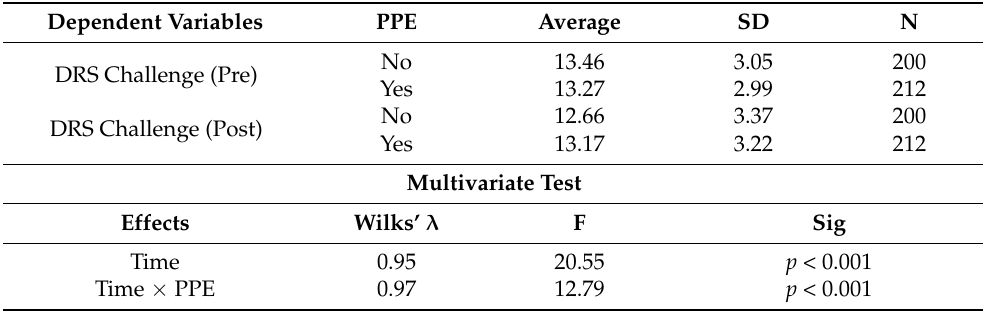
Table 12. Repeated measures ANOVA model of time (i.e., pre- and post-pandemic first-wave effect) and PPE effects on challenge